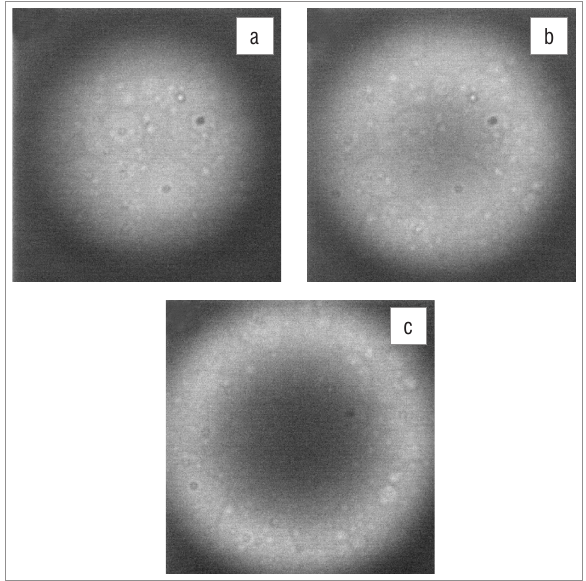
Figure 3: Spontaneous parametric down-conversion is the most efficient method for producing entangled photons; however, the probability of a spontaneous decay into a pair of entangled photons is very low (approximately 1 in every 10 12 photons are down-converted). Therefore, a very sensitive electron multiplier charge-coupled device (CCD) camera is needed to image the ring of photons. (a) Far-field image of the collinear down-converted light from the barium borate (BBO) crystal. (b) Far-field image of the near-collinear down-converted light from the BBO crystal. (c) Far-field image of the non-collinear down-converted light from the BBO crystal. The change from non-collinear to collinear requires a very small change in tilt.